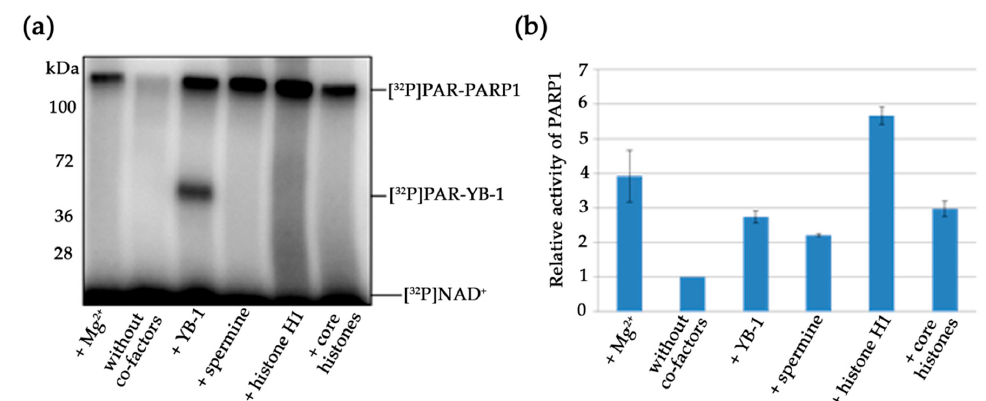
Figure 6. A comparison of the e ff ects of cations, histones, and YB-1 on PARP1 activity. ( a ) Protein PARylationinthepresenceofdi ff erentco-factorsand[ 32 P]NADaccordingtoSDS-PAGEwithsubsequent phosphor imaging. The reaction mixtures contained 100 nM PARP1, 0.5 OD 260 / mL activated DNA, 10 mM EDTA, 5 mM Mg 2 + , 4 µ M NAD + and [ 32 P]NAD (0.4 µ Ci), 1600 nM YB-1, 2 mM spermine 3 + , and 0.054 mg / mL mixture of core histones (H2A, H2B, H3, and H4) or recombinant histone H1, as indicated. ( b ) Quantification of PARP1 activity. PARP1 at 100 nM was incubated with 0.5 OD 260 / mL activated DNA, 4 µ M NAD + and [ 32 P]NAD (0.4 µ Ci) in the presence of 5 mM Mg 2 + , 1600 nM YB-1, 2 mM spermine 3 + , and 0.054 mg / mL mixture [of either core histones (H2A, H2B, H3, and H4) or recombinant histone H1] or 10 mM EDTA, as indicated. 32 P-PAR–modified proteins were TCA-precipitated and counted. The relative level of PAR synthesis was normalized to the level of PAR synthesis catalyzed by PARP1 alone for 15 min in the presence of EDTA. The experiments were conducted at least three times; the histogram presents the means ± SD of three independent